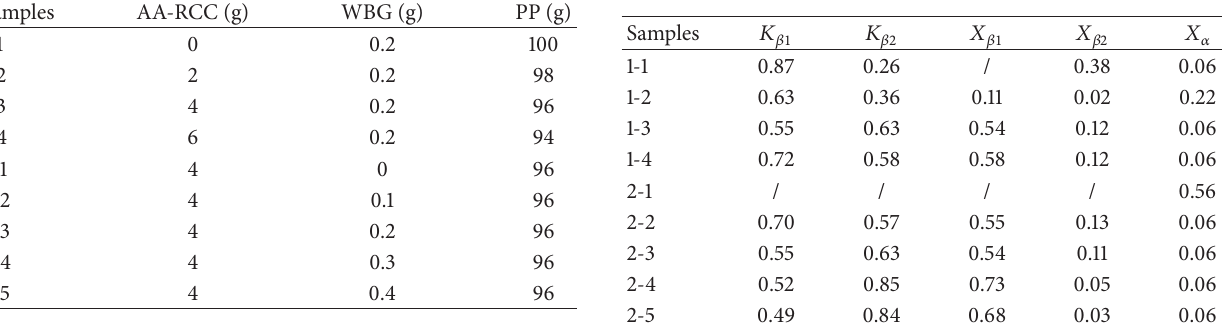
Table 2: The content of the 𝛽 -crystal with dfferent measurement